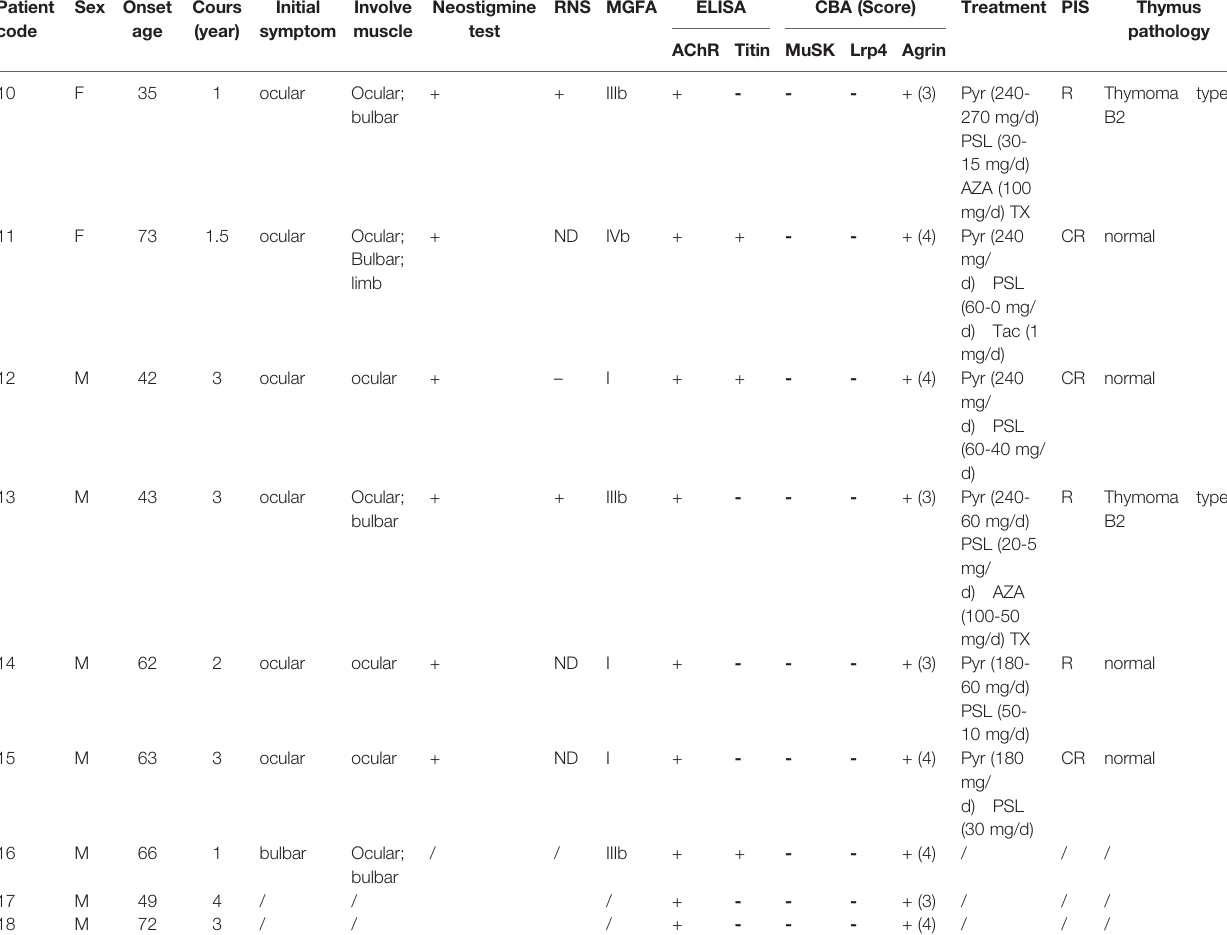
TABLE 3 | Clinical data of Agrin/AChR double positive MG patients.